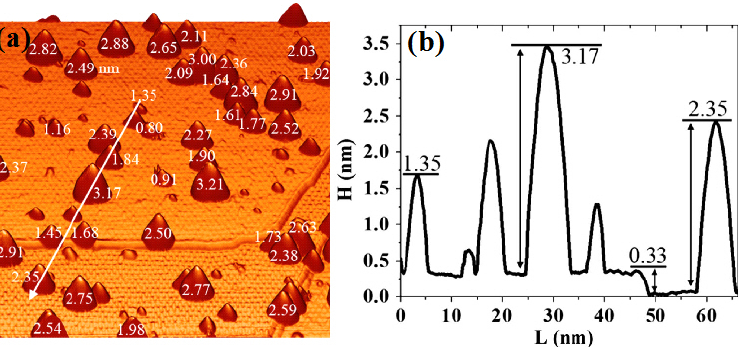
Figure 15. Detailed image of the structure and distribution of Fe islands. ( a ) The area is 100 × 100 nm 2 , n = 7 × 10 − 3 islands/nm 2 , θ = 0.6 ML, T = 450 K, and F = 5.33 × 10 − 2 ML/min. New islands nucleate at a distance as close as 5 nm to preexisting islands; ( b ) Three different size islands are seen from the image and the line